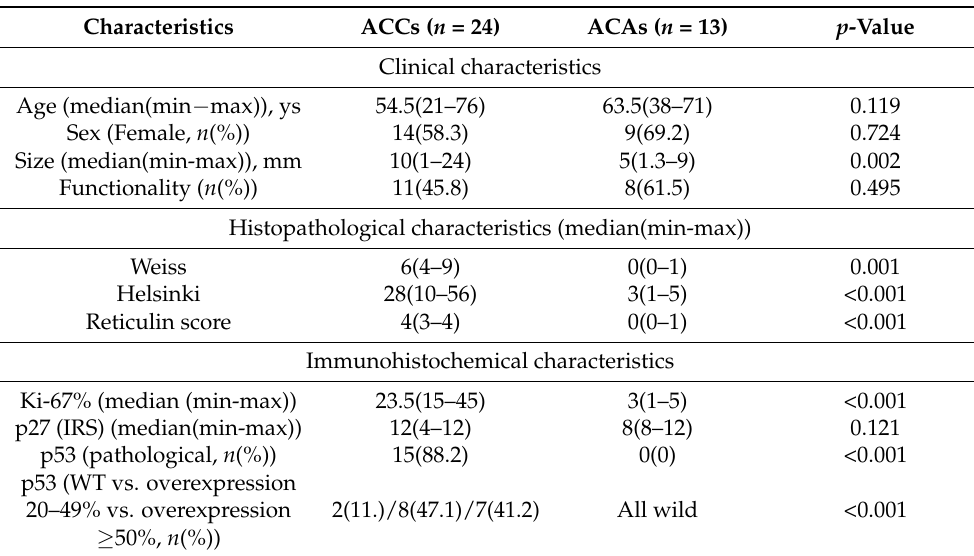
Table 1. Comparisons of the clinical, histopathological and immunohistochemical characteristics of the adrenocortical